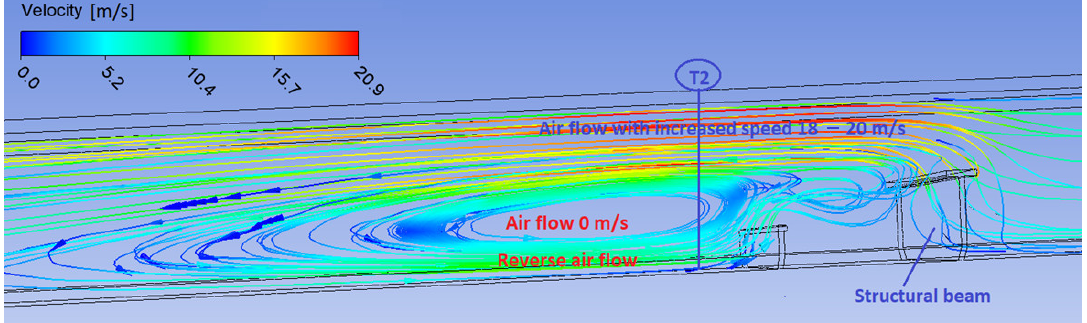
Figure 11. Air velocity; cross sections for the measuring areas T1, T2, and T0 (outlet located at 6 m downstream of the beam); CFD model with a beam size of 288 mm. Based on these effects of the beam on the airflow, it is expected that an important amount of energy is to be wasted in this area of the duct. In order to check the amount of energy wasted due to the structural beams inside the ventilation duct, the total pressure drop across the ventilation duct is calculated for the airflow of 13,200 m 3 /h. Table 4 pre- sents the total pressure drop for the beam height of 288 mm, and Table 5 shows the total pressure drops for the beam size of 388 mm, considering different alternatives for the beams with and without deflectors or holes. Table 4. Total pressure drops for a beam size of 288 mm and an air inlet velocity of 7.9 m/s (the height of the beam is less than half of the ventilation duct height). Description of the CFD Model Pressure Drops With beam, without deflectors 133 Pa With beam, improved with upstream air deflectors 31 Pa With beam, improved with upstream and downstream air deflectors 9.6 Pa Without beam 3.9 Pa